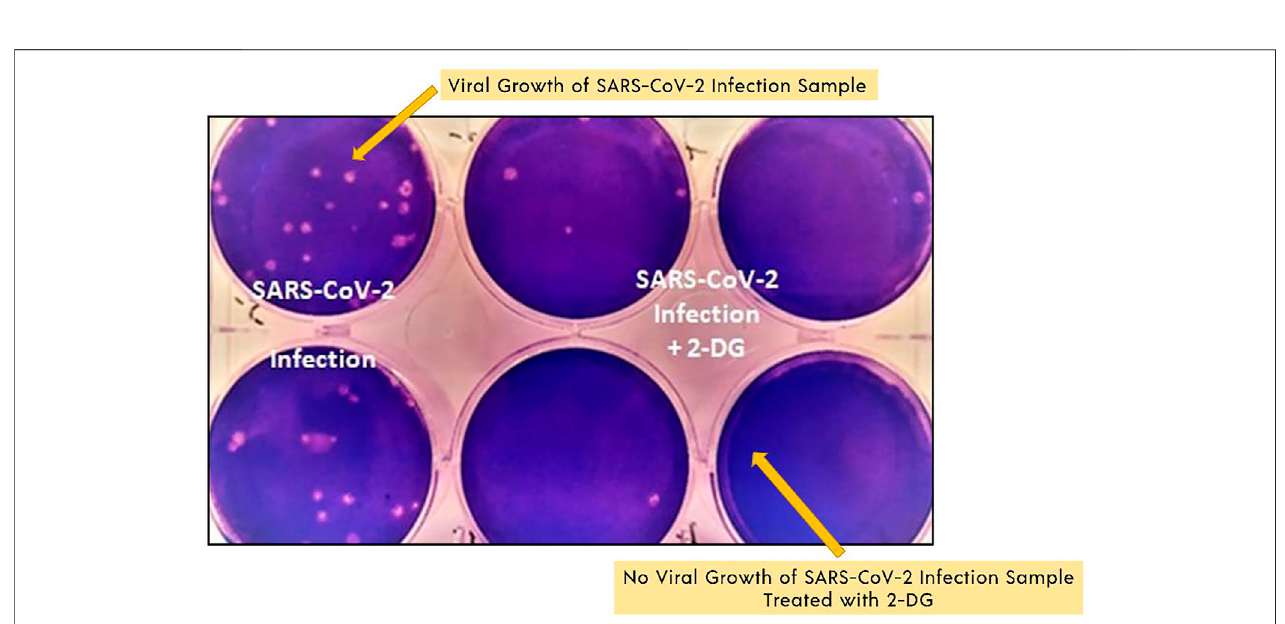
FIGURE 6 | SARS-COV-2 growth inhibition study results with 2-DG. Image reproduced from the Indian government website (Ministry of Defence, 2021a).